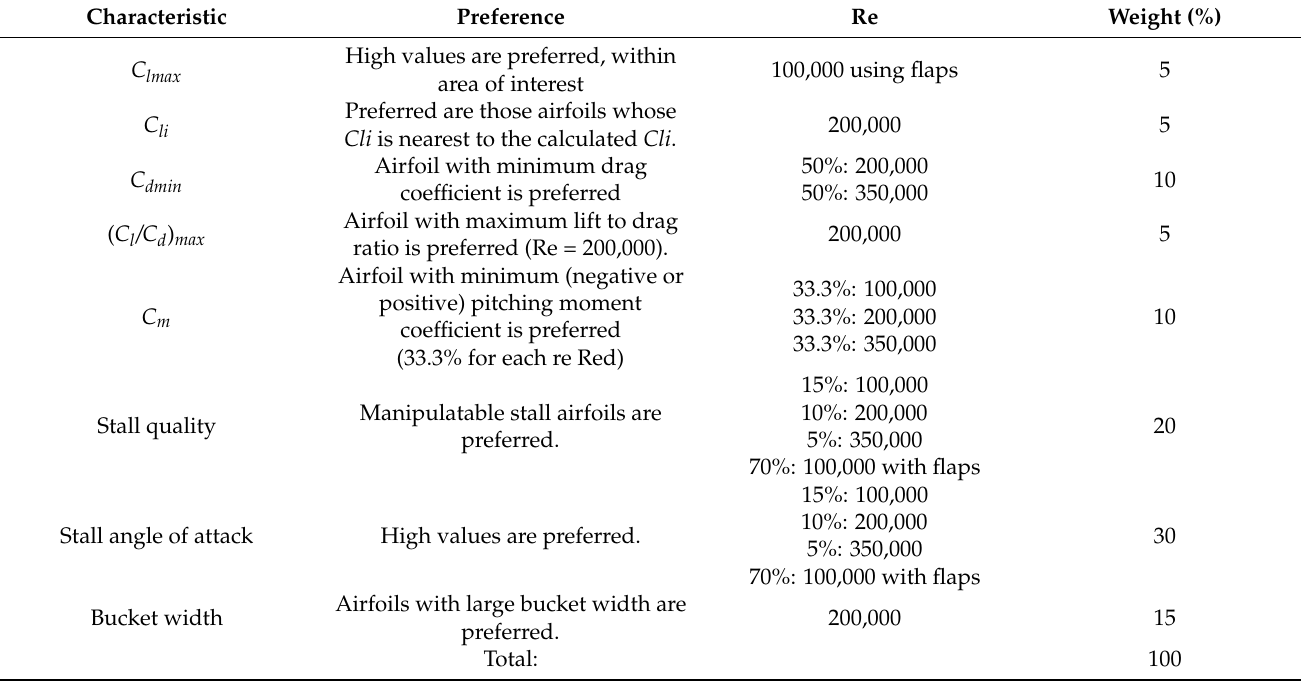
Table 3. Indicative/suggestive weights for airfoils